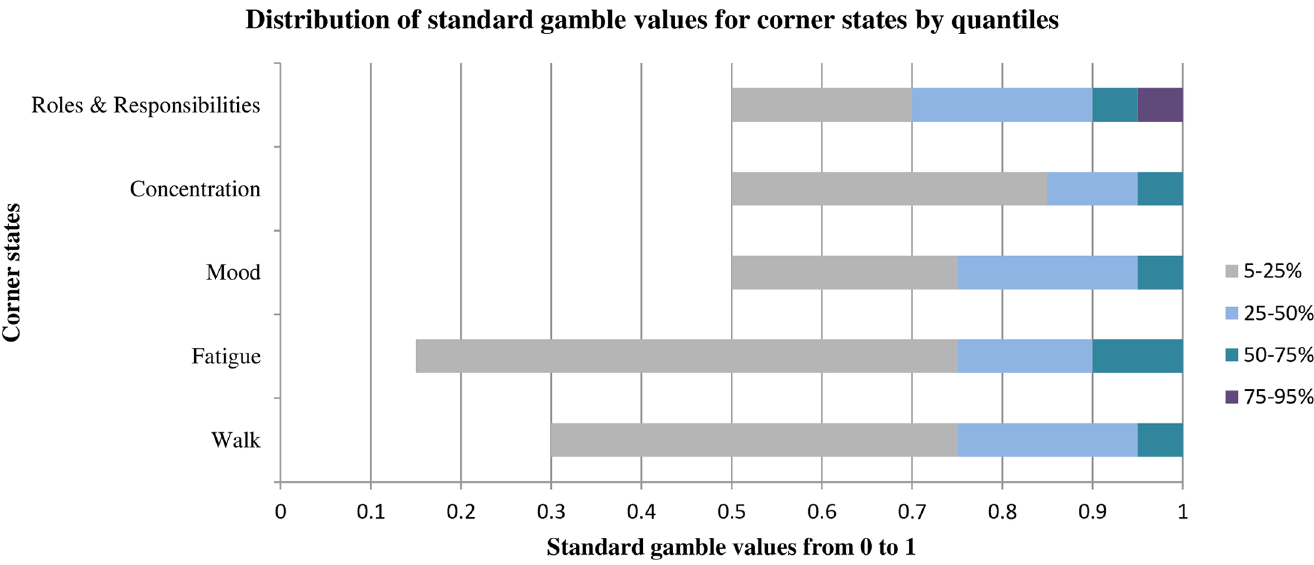
Fig 3. SG values by quantiles for PBMSI corner states in the development sample.